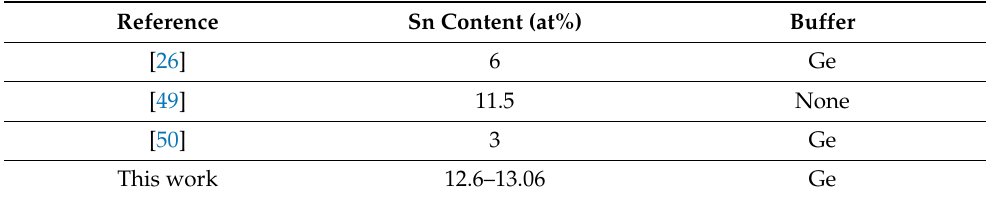
Figure 7. EDX of the sample with Ge 1-x Sn x film as deposited at 240 °C, ( a ) map scanning; ( b ) line scanning. Table 2. Comparison of the Sn content of crystalline Ge 1-x Sn x with those found in other references.